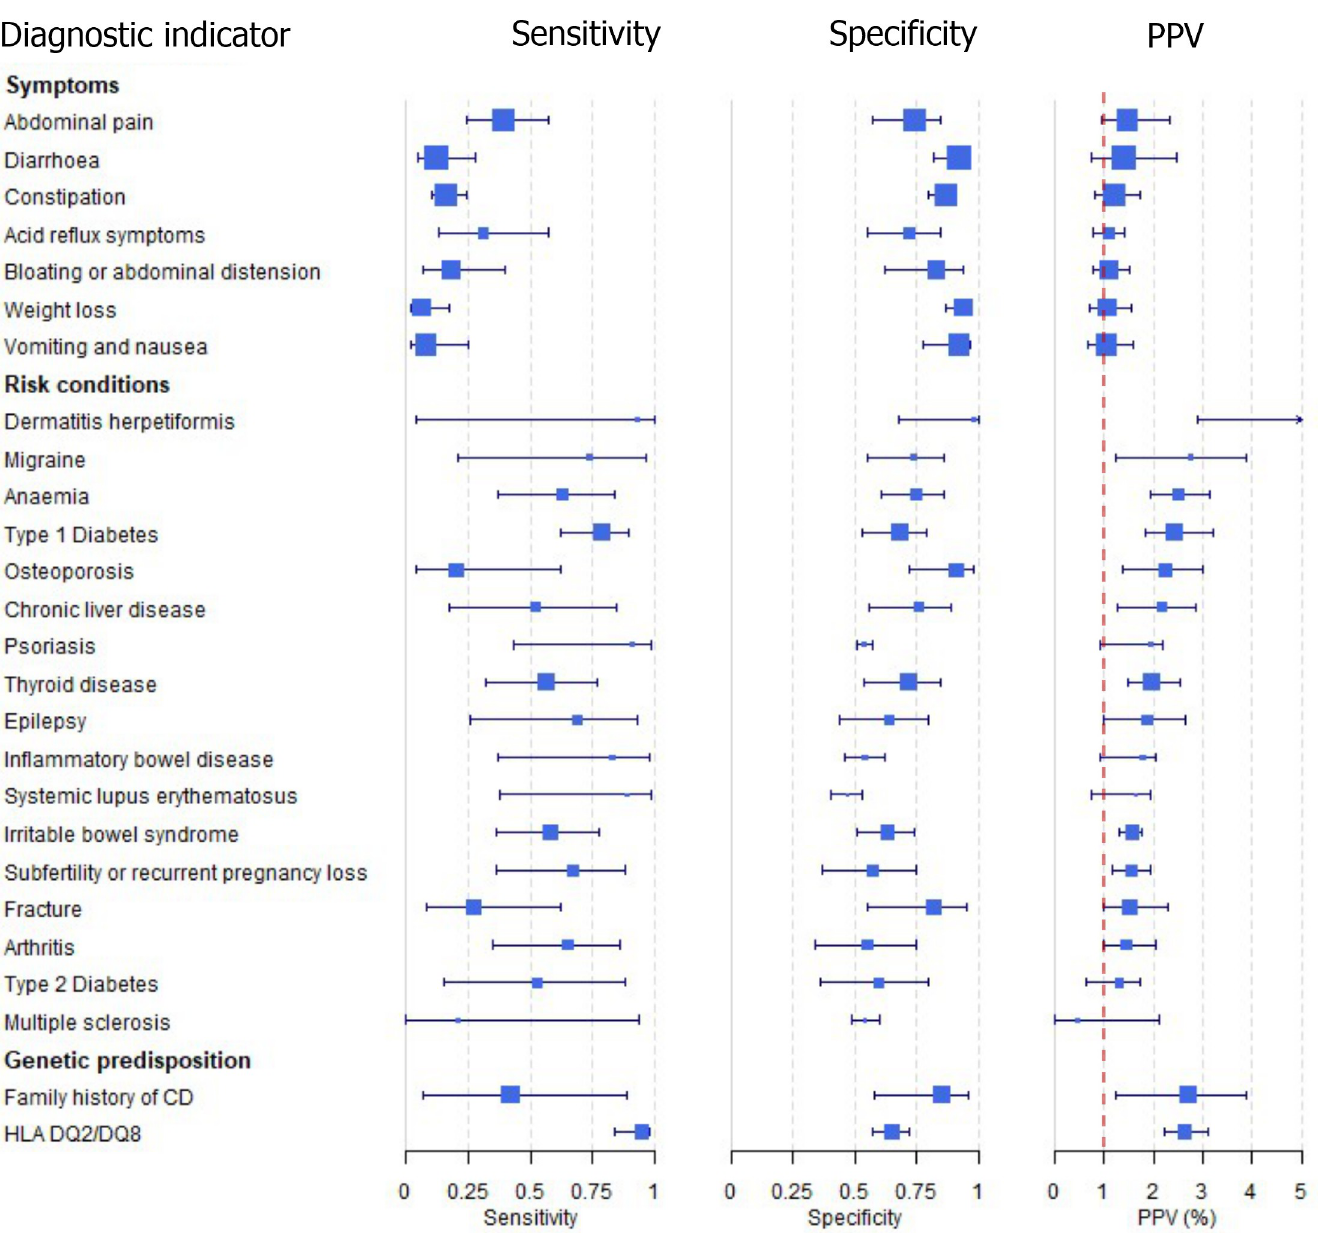
Fig 3. Sensitivity, specificity, and positive predictive values. Meta-analysis results are shown per diagnostic indicator. Positive predictive values (PPVs) were calculated for a population with a CD prevalence of 1% (red dotted line) using the estimated sensitivities and specificities from the meta-analyses. Diagnostic indicators are ordered from high to low PPV per diagnostic indicator group. The area of the box size is proportional to the total number of